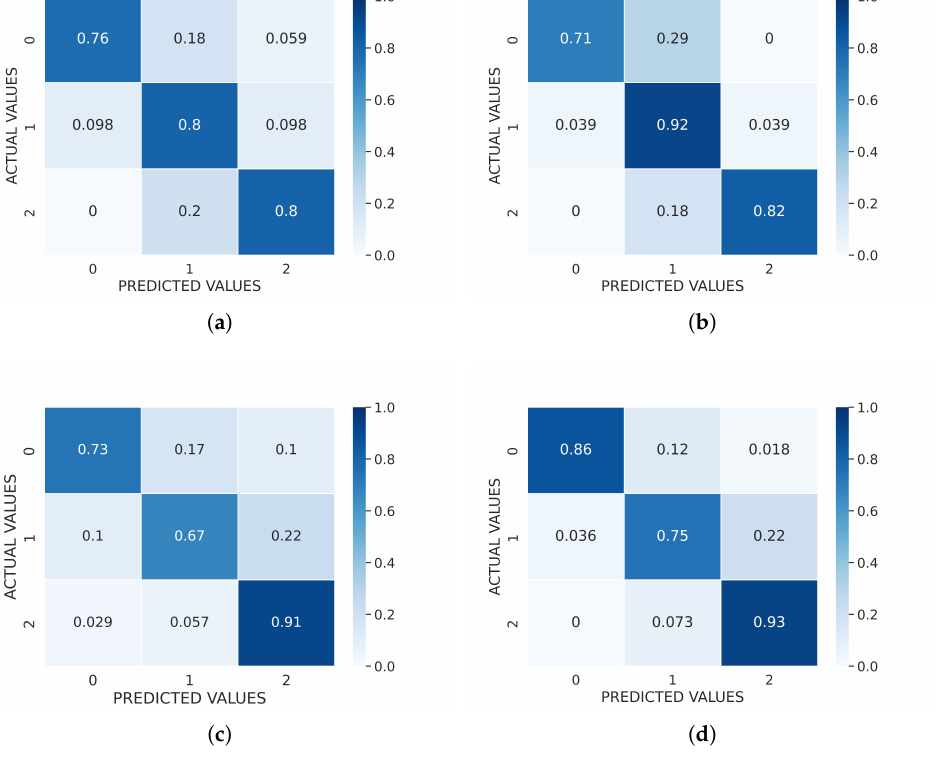
Figure 13. Comparison of confusion matrix for the trained ( a ) VGG16-ANN, ( b ) ResNet50-ANN, ( c ) VGG16-kNN, and ( d ) ResNet50-kNN in the greyscale